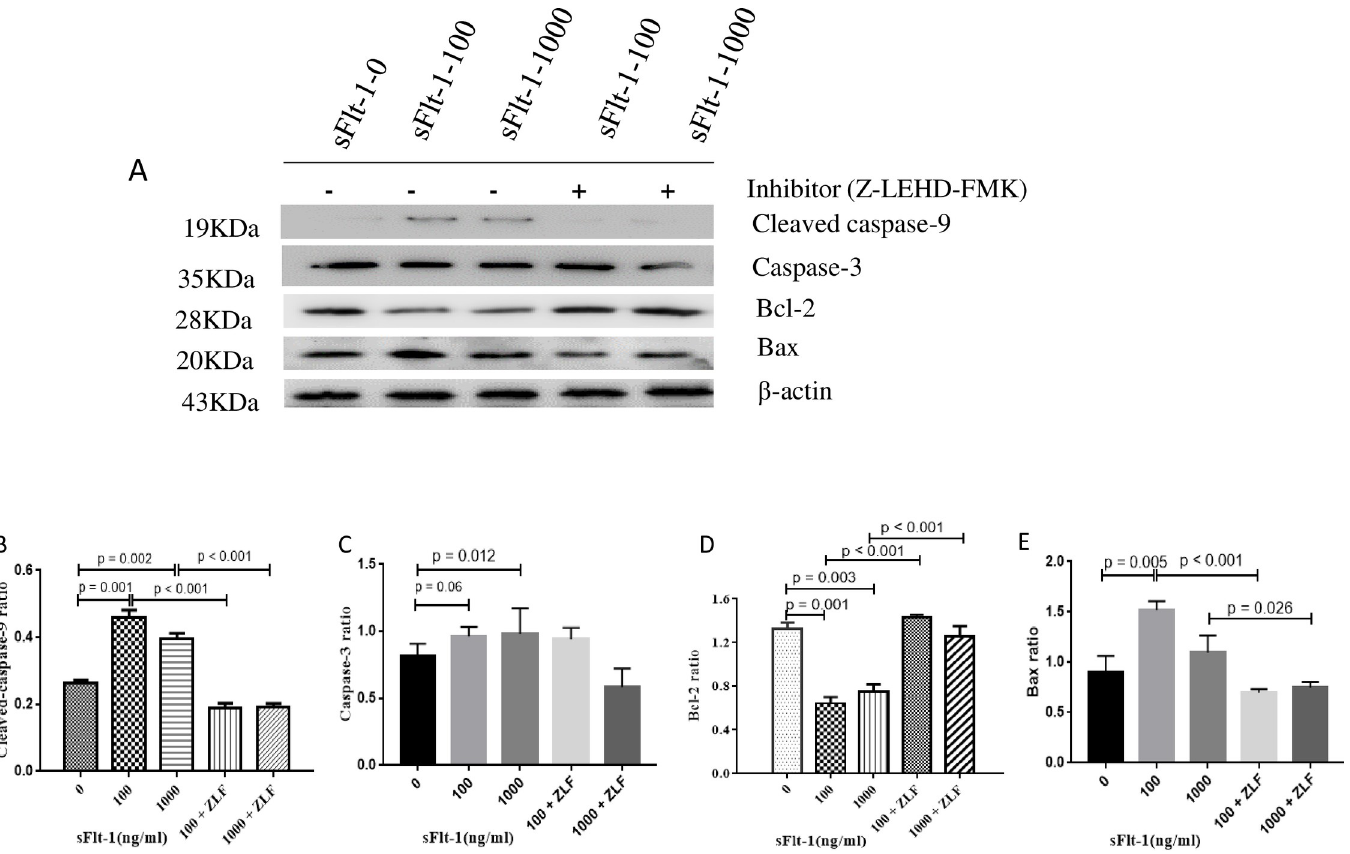
Fig 6. Expression of cleaved-caspase 9, caspase 3, Bcl-2 and Bax in sFlt-1-induced HUVECs with or without Z-LEHD-FMK incubation. The HUVECs were treated with the indicated concentrations of sFlt-1, and then treated with or without Z-LEHD-FMK. The protein expression levels of cleaved caspase-9, caspase-3, Bcl-2, Bax and β -actin were detected by western blotting (A). Relative protein levels of caspase-9 (B), caspase-3 (C), Bcl-2 (D) and Bax (E) versus β -actin are presented as histograms. Results are the means ± standard deviation of three independent experiments.